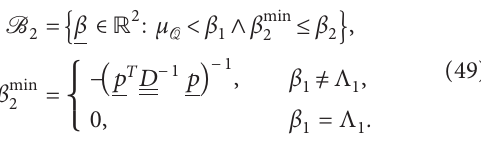
, Λ 􏼈 􏼉 and 1 2 isdescribed 2 � μ Q . 1